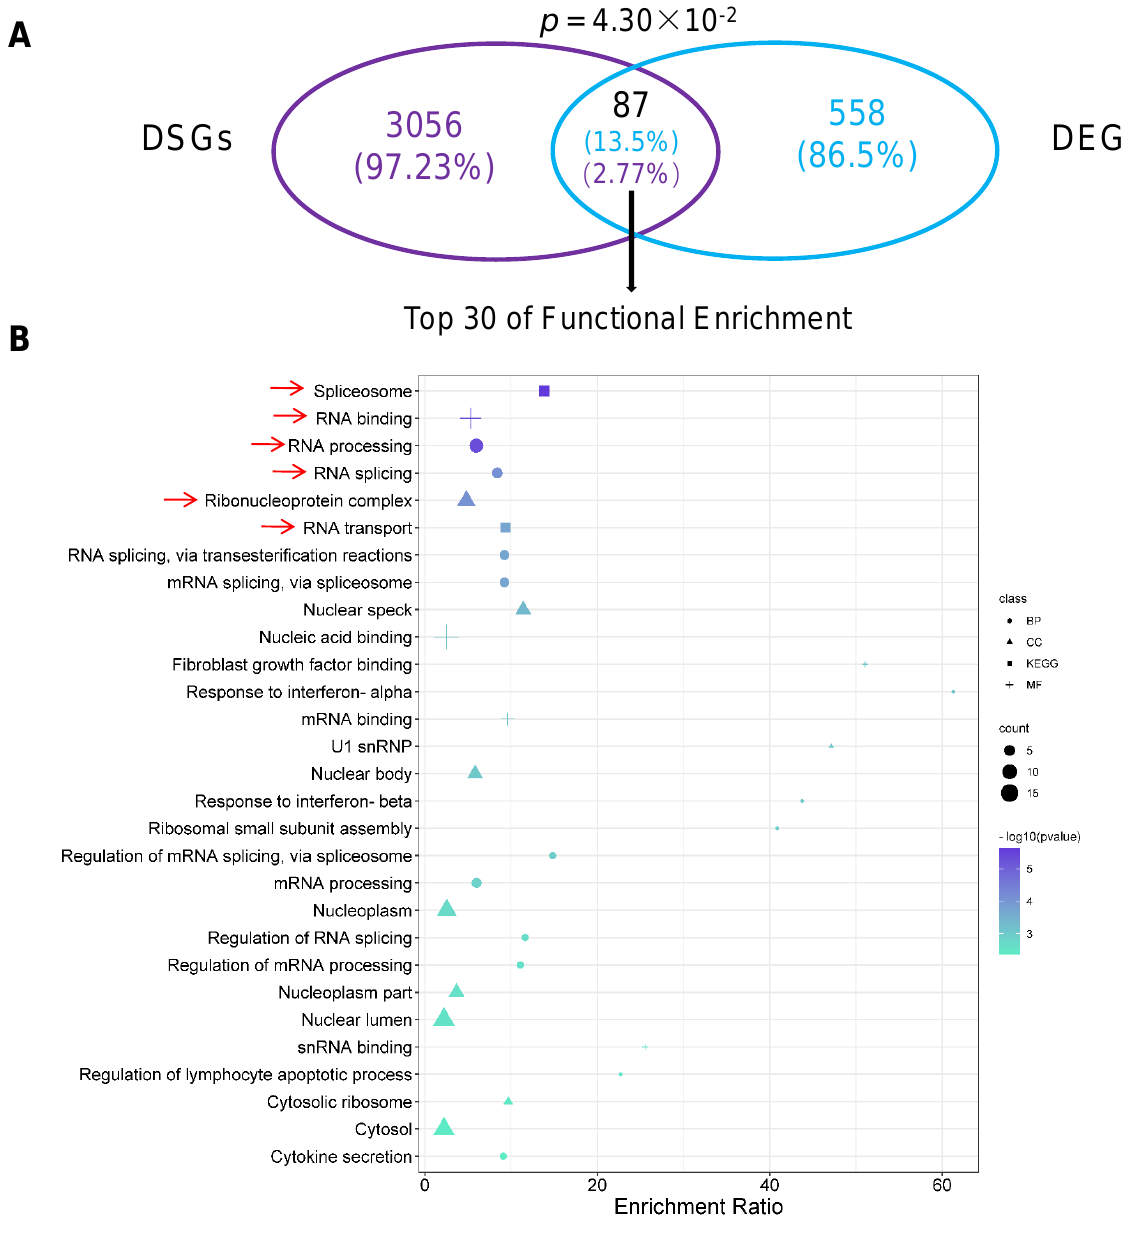
Figure 5. Genes presented in both differentially spliced (DSGs) and differentially expressed (DEGs). ( A ) Venn diagram of DSGs and DEGs. ( B ) Functional annotation of the overlapping genes. BP: biological processes; CC: cellular components; MF: molecular